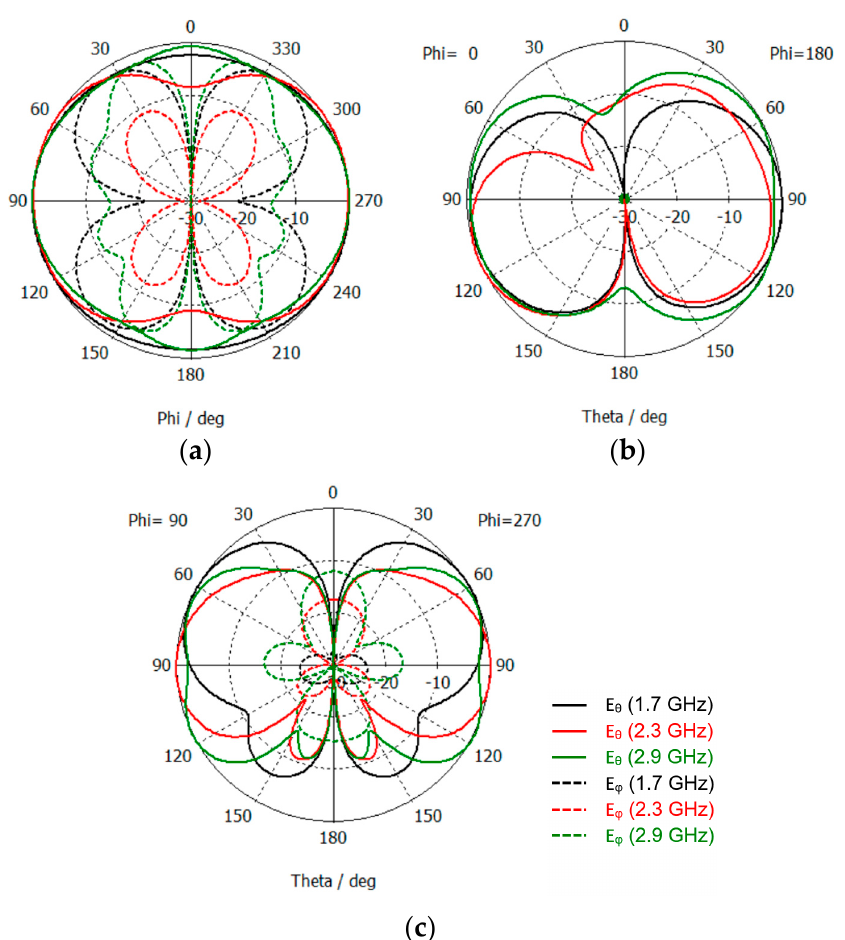
Figure 3. CST simulated far-field 2D radiation pattern results of the straight monopole. ( a ) H-plane (XY); ( b ) E-plane (XZ); ( c ) E-plane (YZ).